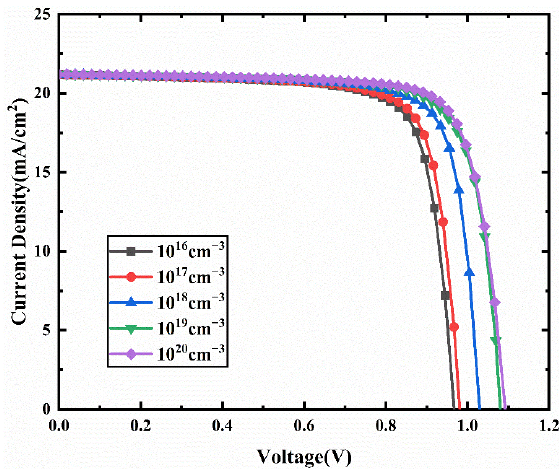
Figure 9. Comparison of J-V characteristic curves for different donor density (N D ).